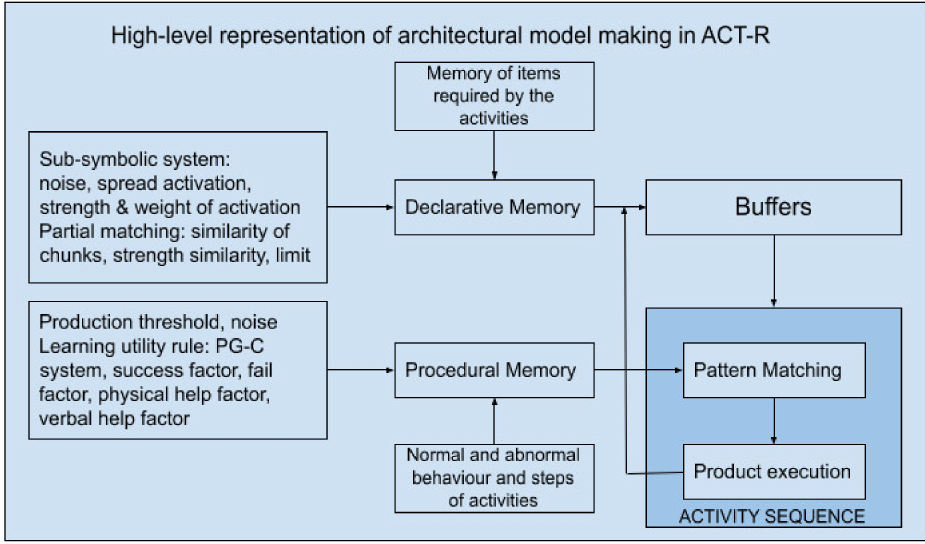
Figure 2. High-level representation of architectural model making in